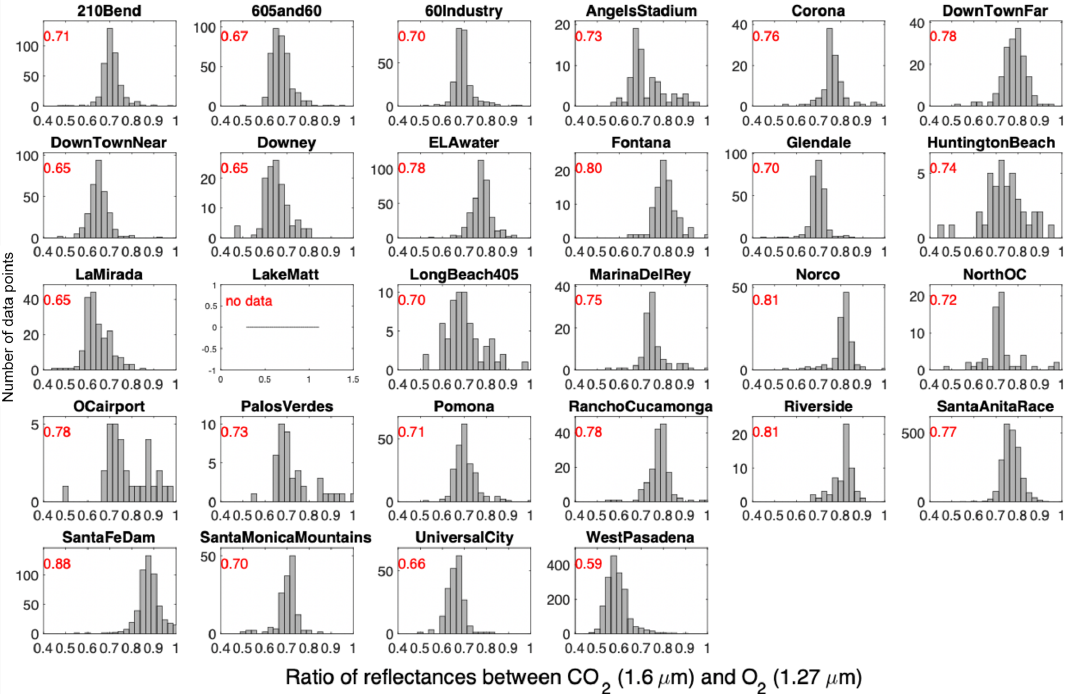
Figure A5. Histogram of the ratio of reflectance between the WCO 2 and O 2 bands for all the surface targets. The reflectance values are obtained from GFIT3 retrievals. The number in red is the average ratio for the surface target.